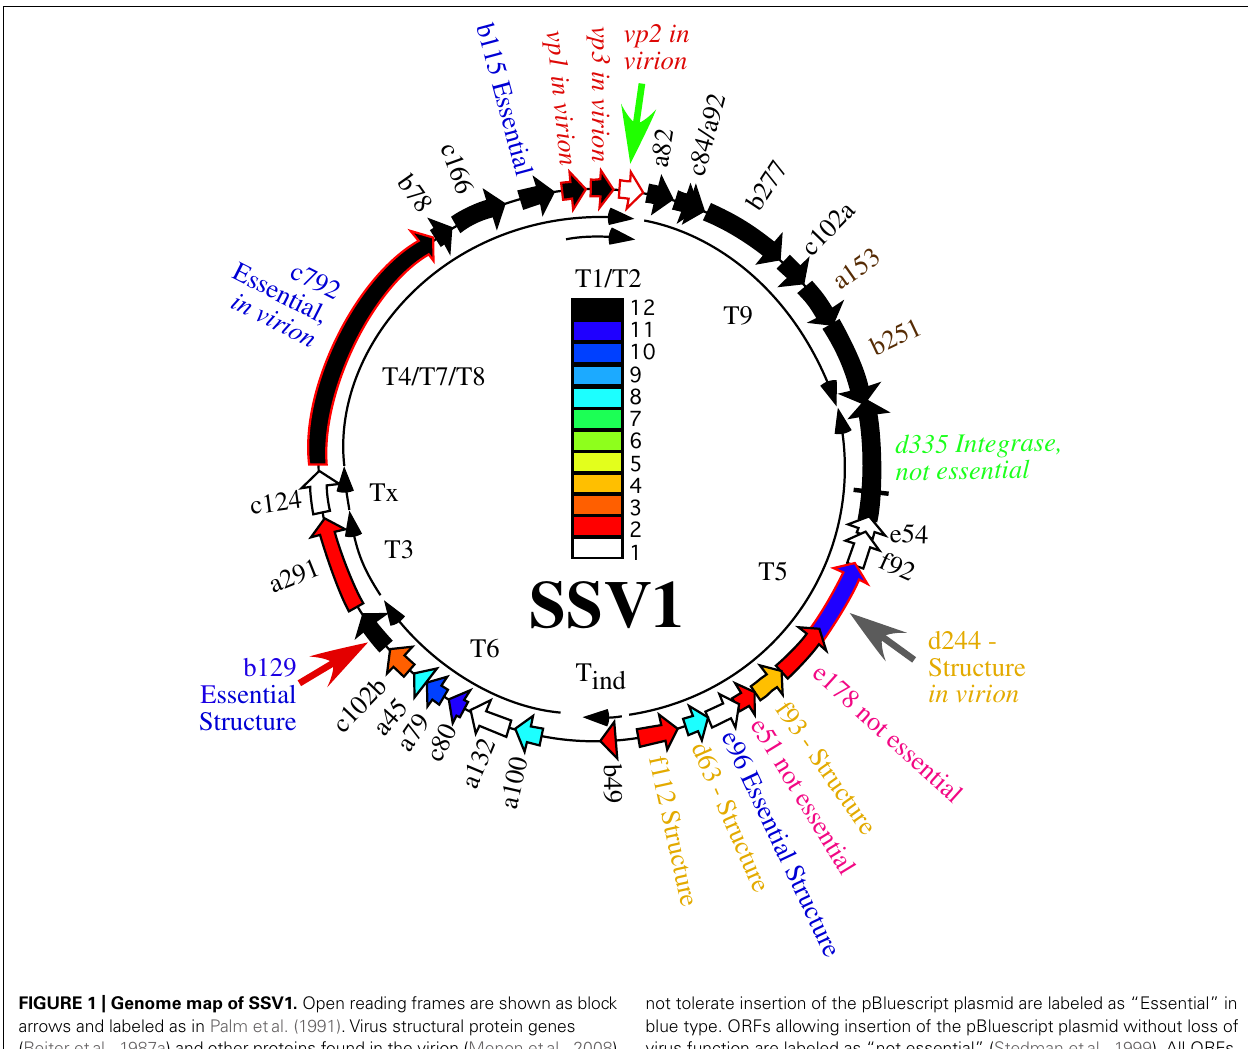
FIGURE 1 | Genome map of SSV1. Open reading frames are shown as block arrows and labeled as in Palm etal. (1991).Virus structural protein genes (Reiter etal., 1987a) and other proteins found in the virion (Menon etal., 2008) are outlined in red and labeled as “in virion.” Conservation of open reading frames in 12 canonical SSV genomes (SSV1, SSV2, SSV3, SSV4, SSV5, SSVRH, SSVK1, SSVL, SSVKM1, SSVKU1, SSVL2, and SSVGV1; Redder etal., 2009; Held andWhitaker, 2009; Stedman, unpublished) is listed with the color code in the middle of the genome with ORFs conserved in 12 genomes in black, ORFs conserved in 11 genomes in dark blue, etc. ORFs which did